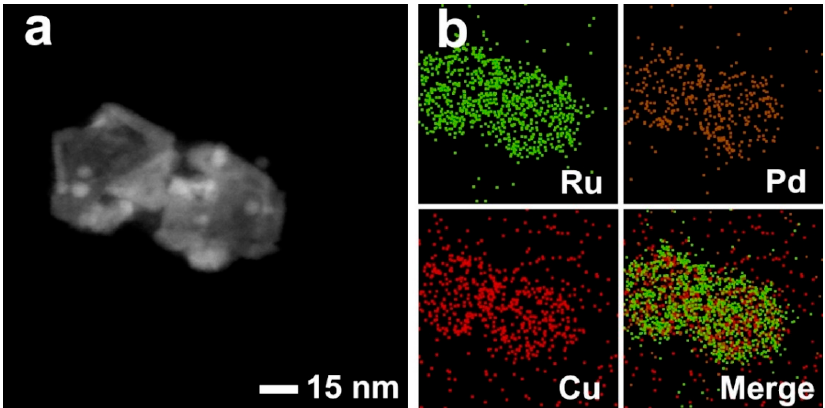
Figure 4. ( a ) HAADF-STEM and ( b ) EDX mapping images of the Pd 19 Cu 25 Ru 56 nanoplates.